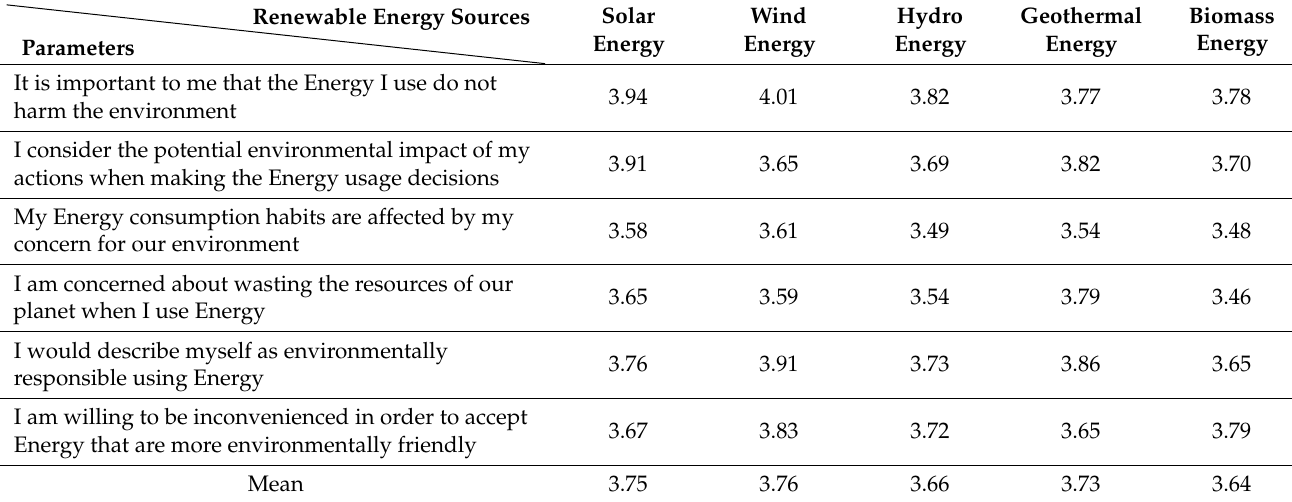
Table 8. Mean GREEN consumer values for renewable energy